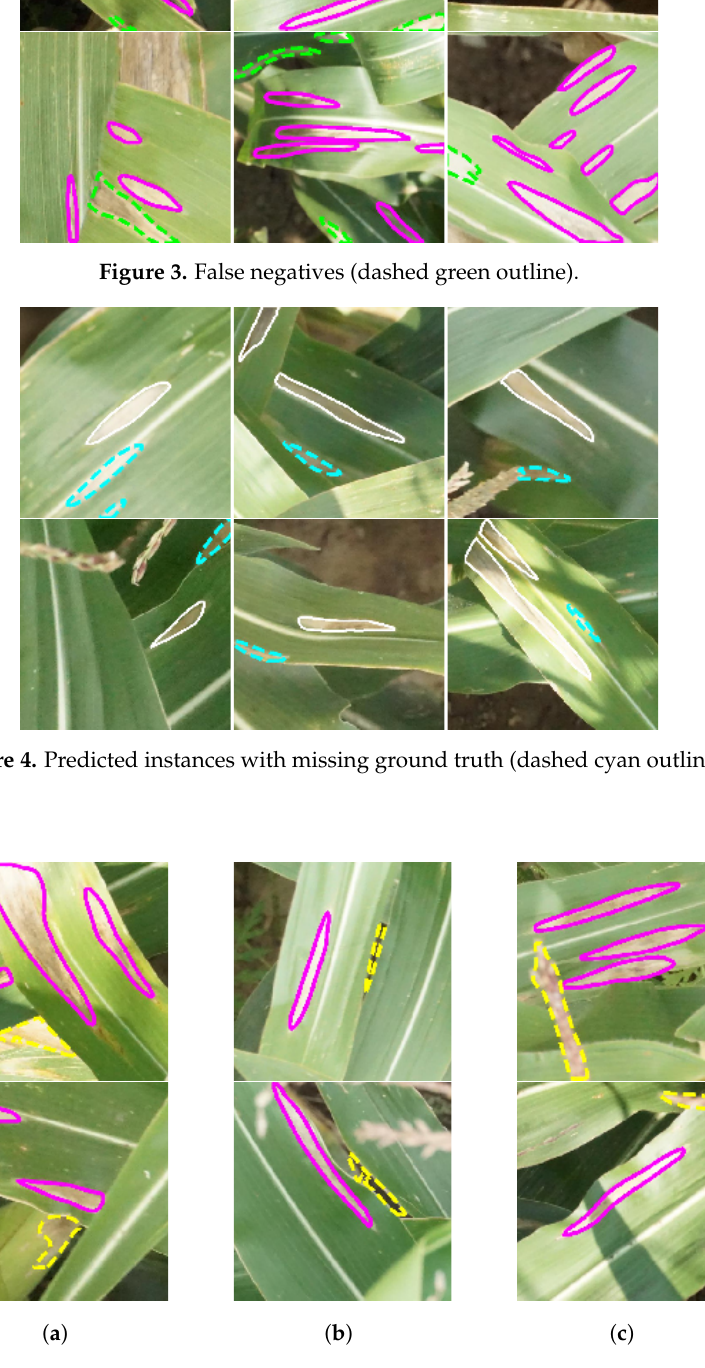
Figure 5. Examples of false positive instances (dashed yellow outline) caused by partially ( a ) occluded senescence, ( b ) patches of soil, and ( c ) senesced male